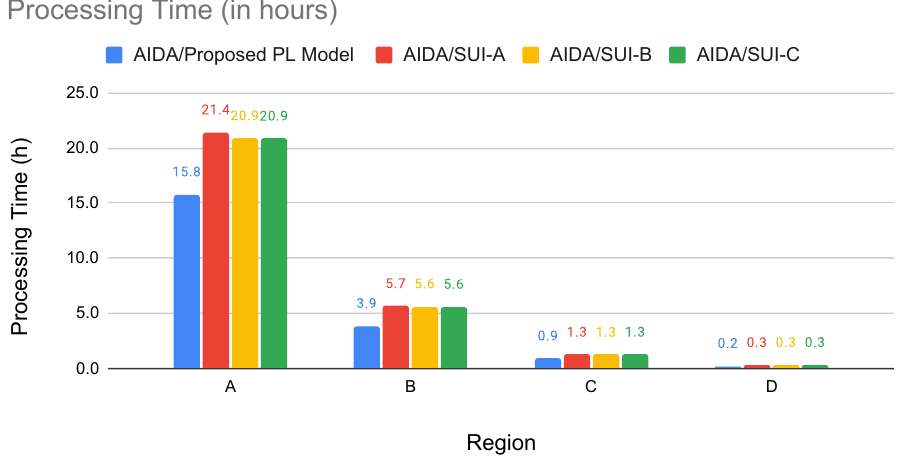
Figure 9. Processing time (in hours) consumed for the execution of the AIDA method using its original path loss model (AIDA/proposed PL model) compared to the values demanded by the AIDA method using the Erceg-SUI path loss model for the terrain Category A (AIDA/SUI–A), Category B (AIDA/SUI–B), and Category C (AIDA/SUI–C). The chart compares the performance of AIDA for the Regions A, B, C, and D, used in the